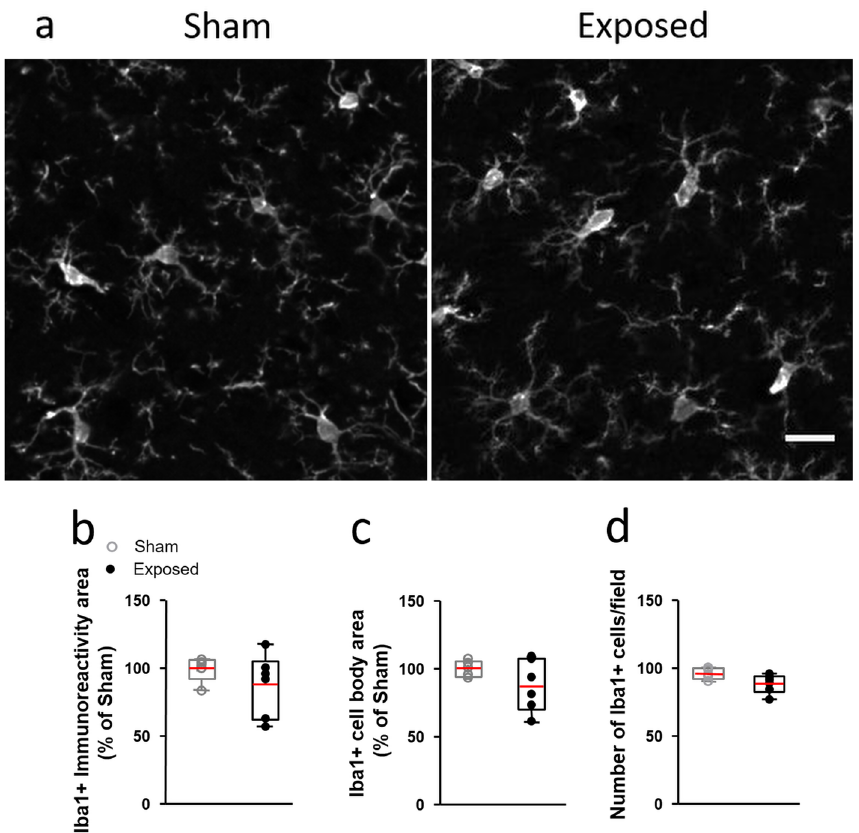
Figure 3. Microglia in the auditory cortex of LPS-injected rats after LTE or Sham exposure. ( a ) Representative stacked views of microglia stained with anti–Iba1 antibody in coronal sections of the auditory cortex from LPS–injected rats that were perfused 3 to 4 h after Sham or LTE exposure (exposed). Scale bar: 20 µm. ( b – d ) Morphometric assessment of microglia 3 to 4 h after sham (open dots) or LTE–exposure (exposed, dark dots). ( b , c ) Spatial coverage of the microglial marker Iba1 ( b ) and area of Iba1-positive cell bodies ( c ). Data represents the area of anti-Iba1 staining normalized to mean values from Sham-exposed animals. ( d ) Counts of anti-Iba1- stained microglial cell bodies. Differences between Sham (n = 5) and LTE (n = 6) animals were not significant (p > 0.05, unpaired t- test). The top and bottom of the box, and the upper and lower lines indicate 25th–75th percentiles and 5th–95th percentile respectively. The mean value is marked in red in the box.